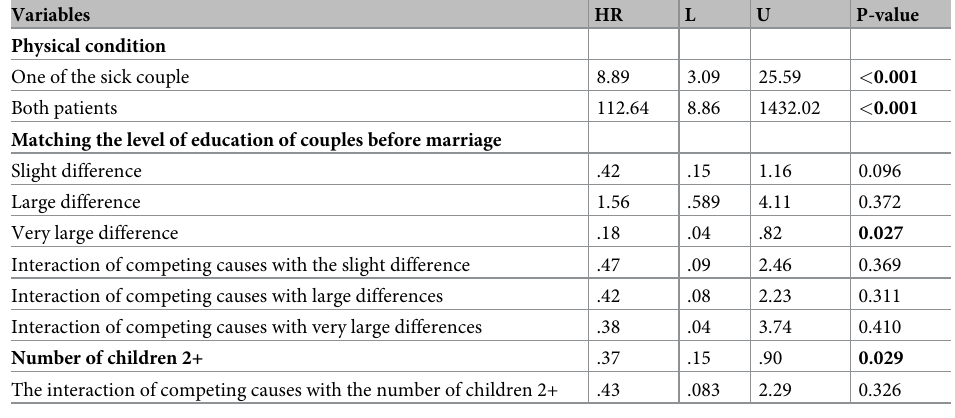
Table 6. Results of Lunn-McNeil multivariate analysis for the competing cause of the role of moral- religious com- mitment in choosing a spouse. Variables